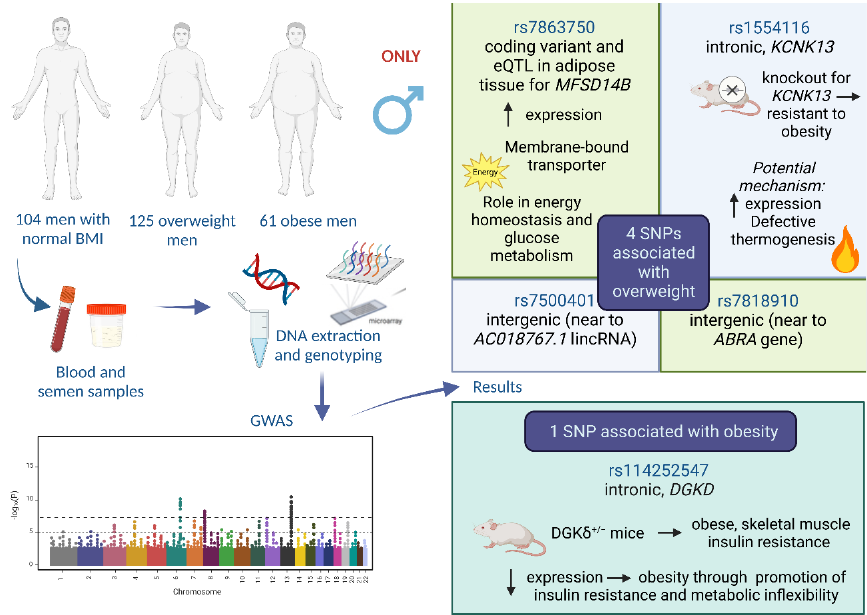
Figure 3. Summary of the methodology and the results of the present study. In brief, the genome- wide association study (GWAS) that included 104 control, 125 overweight, and 61 obese subjects revealed four SNPs associated with overweight (rs7818910, rs7863750, rs1554116, and rs7500401) and one SNP (rs114252547) associated with obesity in males. The potential role of the identified SNPs in overweight and obesity is also presented based on previous studies and research [29–32,41,42,47–50]. The figure was created with Biorender.com.